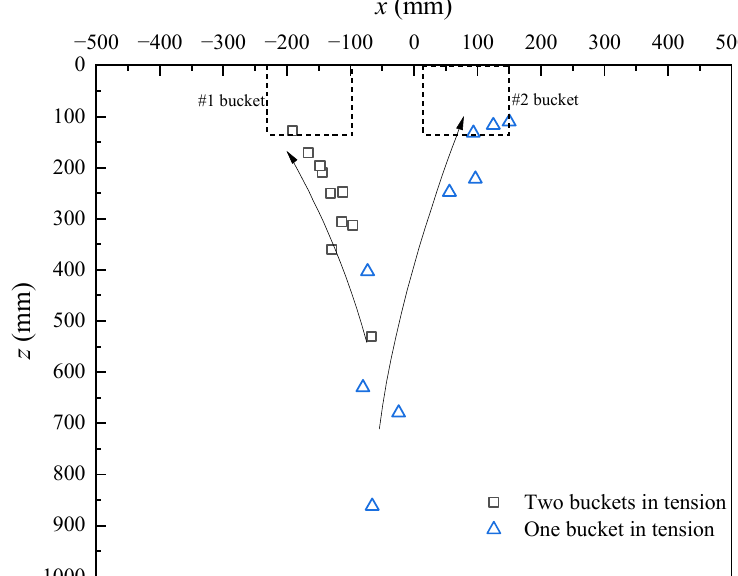
Figure 8. Evolution of rotation center with the lateral monotonic loading.